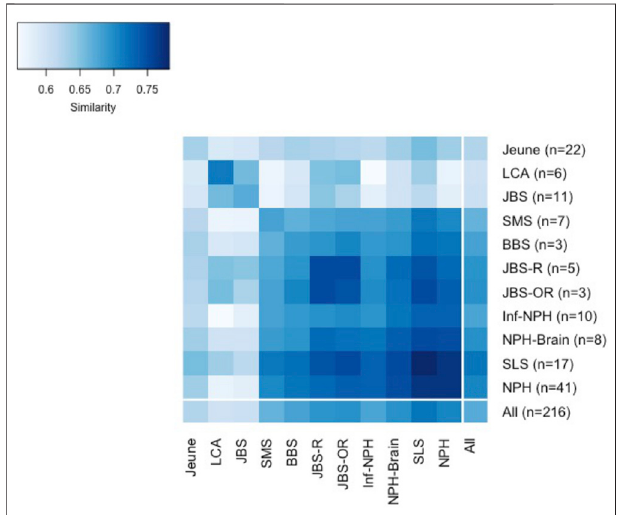
FIGURE 4 | Internal-external group average similarities for 11 most frequent ciliopathy